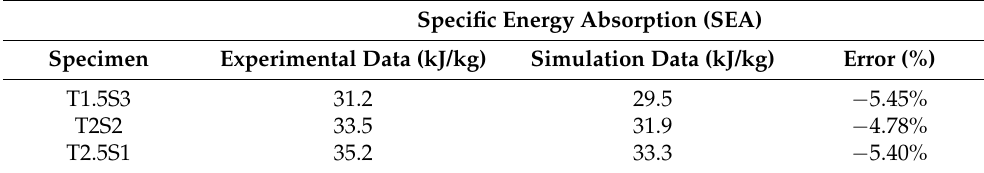
Table 9. Comparison of experimental and numerical results.